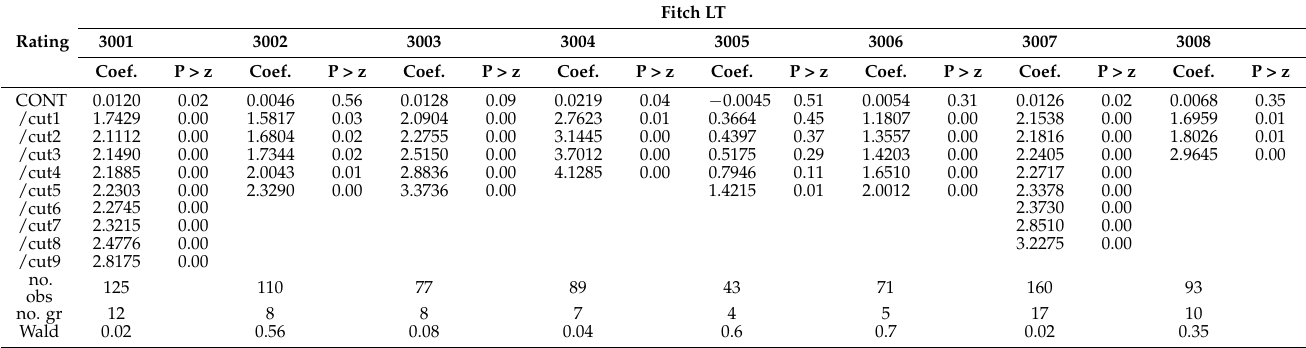
Table 9. Impact of the ESG Controversies Scores on the Fitch long-term issuer credit ratings by sector.